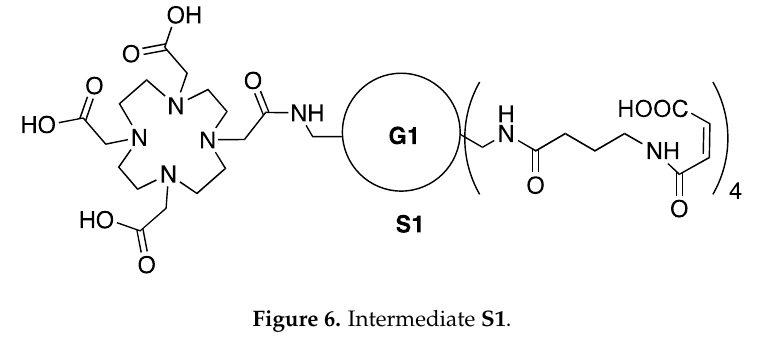
Figure 4. Intermediate S1 . Figure 6. Intermediate S1